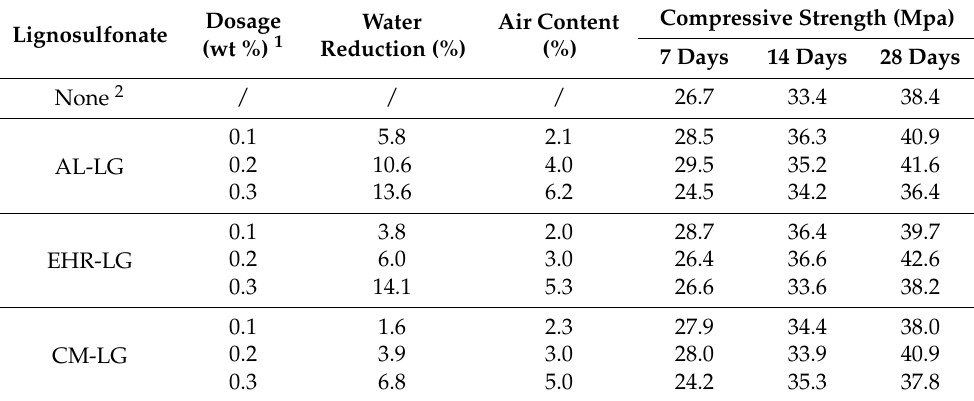
Table 2. The effects of addition of AL-LG, EHR-LG, and CM-LG on these properties of concrete Dosage Lignosulfonate